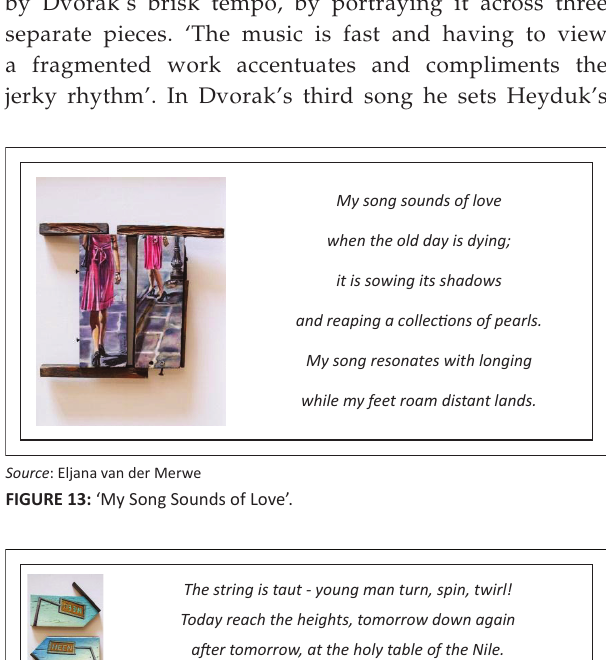
FIGURE 16: ‘Songs My Mother Taught Me’.